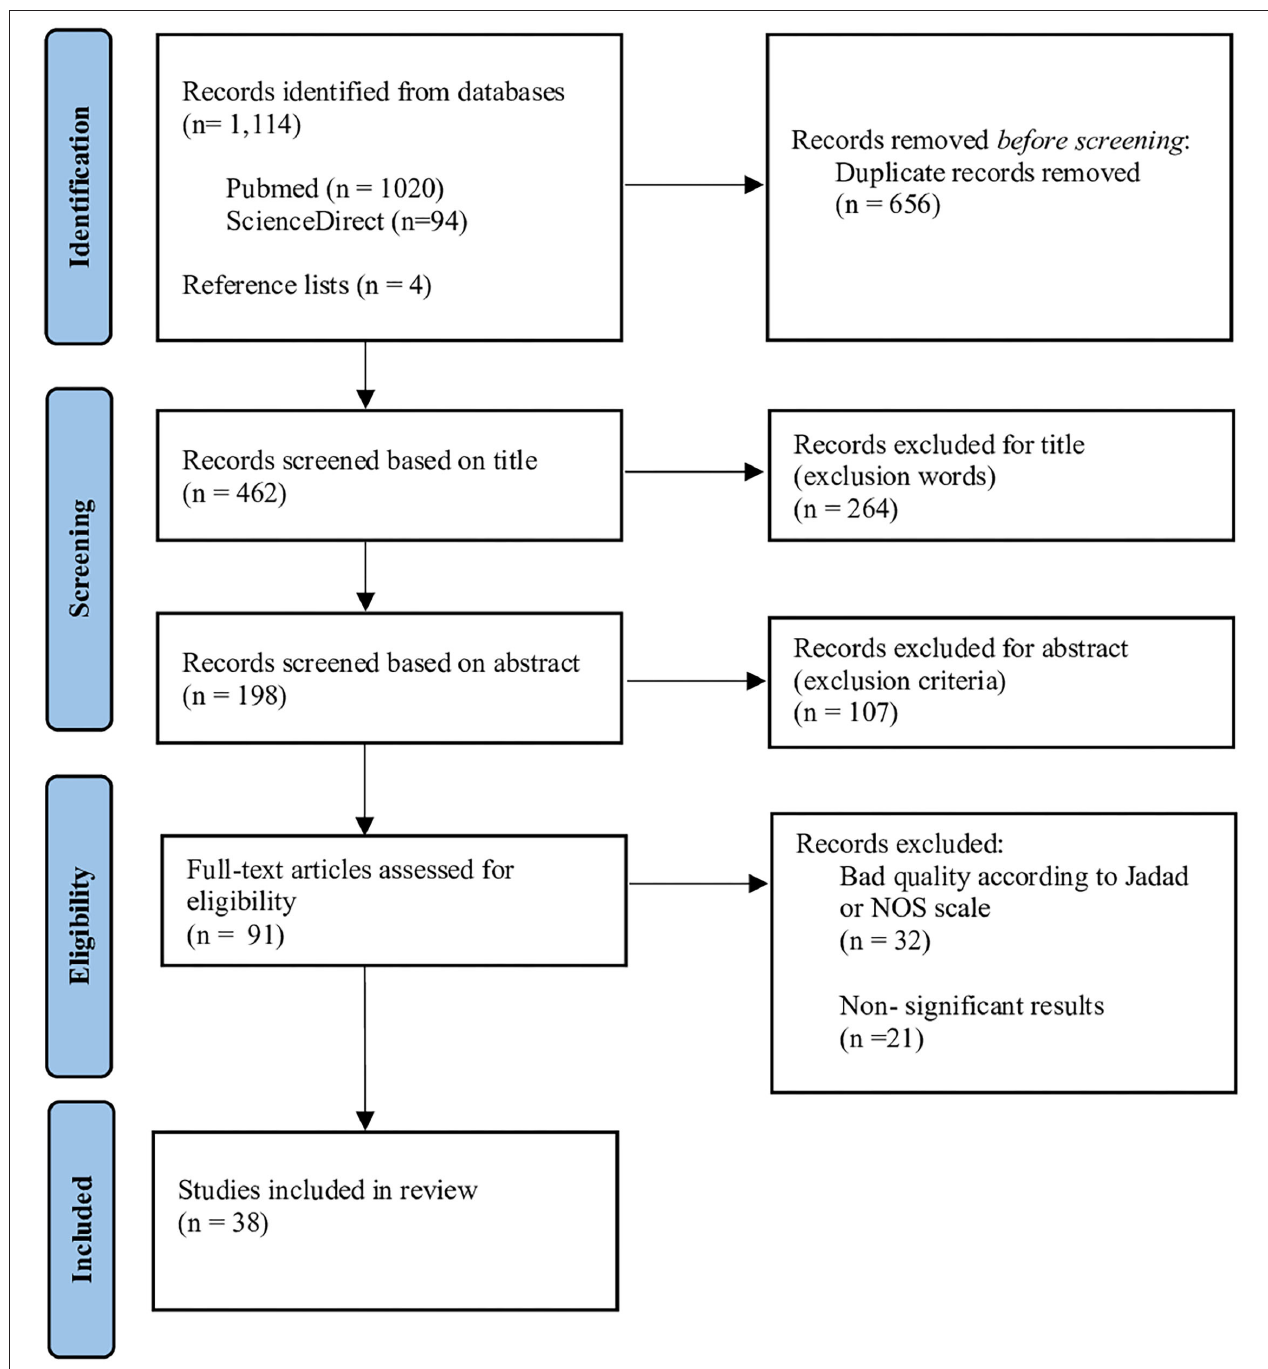
FIGURE 1 | PRISMA flow diagram summarizing the selection process of the included